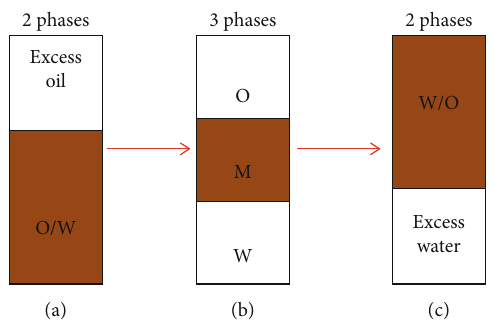
Figure 14: Winsor microemulsion type. (a) Winsor I. (b) Winsor II. (c) Winsor III.